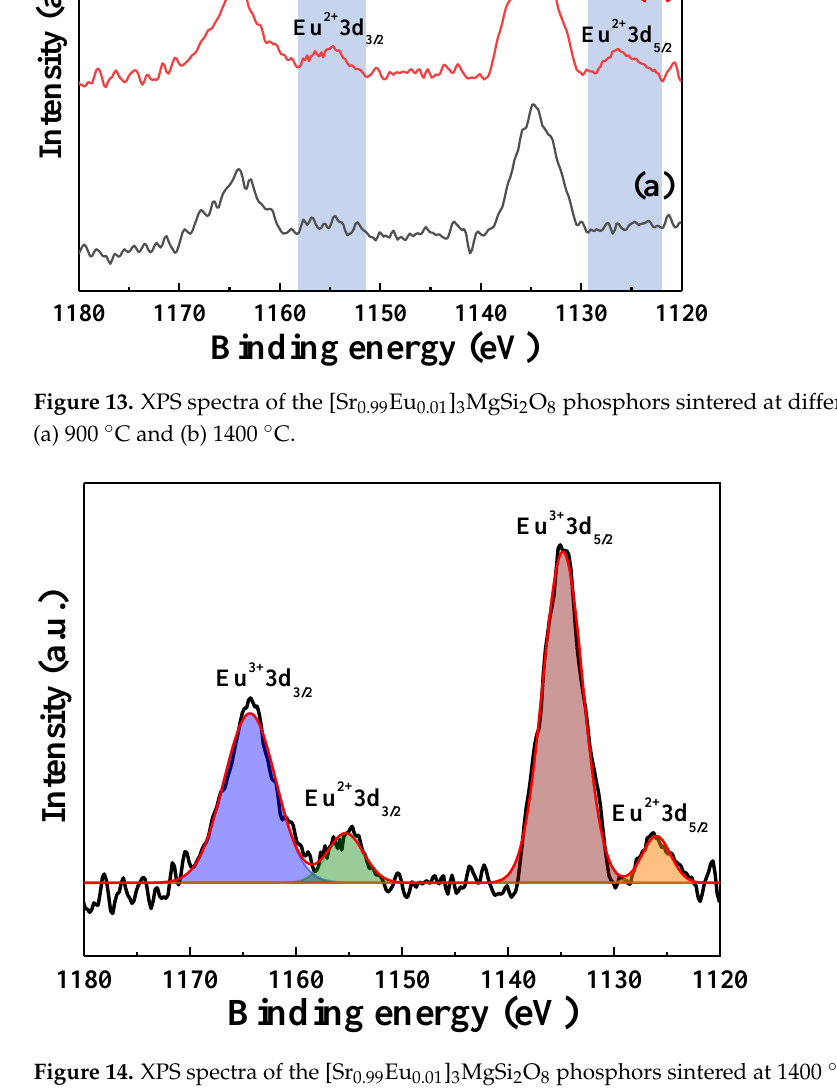
Figure 14. XPS spectra of the [Sr 0.99 Eu 0.01 ] 3 MgSi 2 O 8 phosphors sintered at 1400 °C. Figure S5 displays the fluorescent decay curves of the [Sr 0.99 Eu 0.01 ] 3 MgSi 2 O 8 phosphors excited at 280 nm and monitored at 457 nm. The data fit well with a double-exponential curve. The average luminescence lifetimes of the [Sr 0.99 Eu 0.01 ] 3 MgSi 2 O 8 phosphors sintered at 1200, 1300, and 1400 ◦ C were calculated from Equation (2) to be 1.074, 1.144, and 1.197 ms, respectively. The parameter τ * decreased with sintering temperature. This result demonstrates that energy transfer occurred between the Eu 2+ ions located at the Sr 2+ sites [32]. MgSi 2 O 8 phosphors sintered at different temperatures. The CIE chromaticity diagram was increased from 1200 to 1400 ◦ C, the CIE chromaticity coordinates shifted from a light blue region ( x = 0.1659, y = 0.1382) to an ultramarine blue region ( x = 0.1494, y = 0.0942). Therefore, the optimal sintering temperature in the production of blue phosphors is 1400 ◦ C. Images of the [Sr 0.99 Eu 0.01 ] 3 MgSi 2 O 8 phosphors sintered at different temperatures